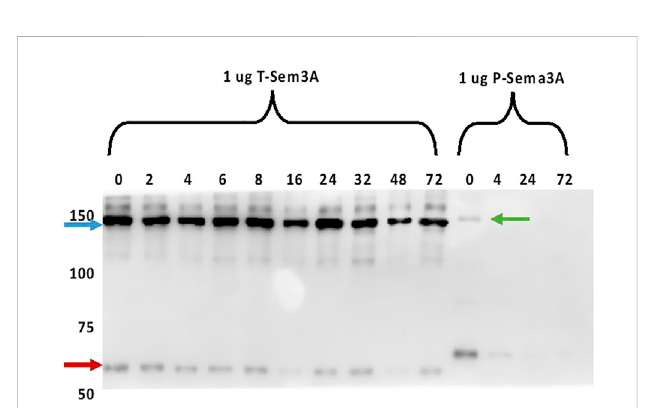
FIGURE 4 Truncated sema3A is a stable protein. One µg of puri fi ed P- and T-sema3A were incubated in 100 µL elution buffer in a 96-well plate at 37 ° Cfor0-72 h.Attheindicatedtimepoint,proteinswerecollected, and a sample buffer (without Dithiothreitol redox reagents) was added. All the samples were loaded on SDS-PAGE gel, then the membrane was immunoblotted with anti-human sema3A polyclonal antibody directed against the N-terminal (26-771 amino acids), followed by anti-goat HRP antibody. The bound antibodies were visualized using the EZ-ECL method and the blots were viewed by ImageQuant LAS 4000 machine and analyzed using ImageQuant TL Analysis software. The blue arrow points to the T-sema3A dimer (~140 kDa), while the red arrow points to T-sema3A monomer (~68 kDa), and the green arrow points to the P-sema3A dimer (~160